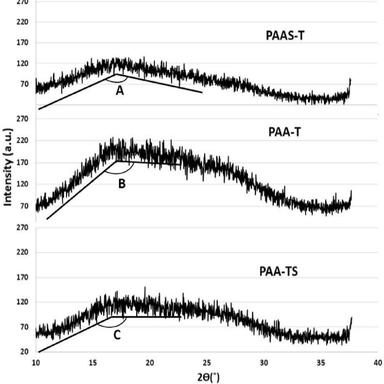
The X-ray diffraction analysis of the PI matrices of PAAS-T, PAA-T and PAA-TS.